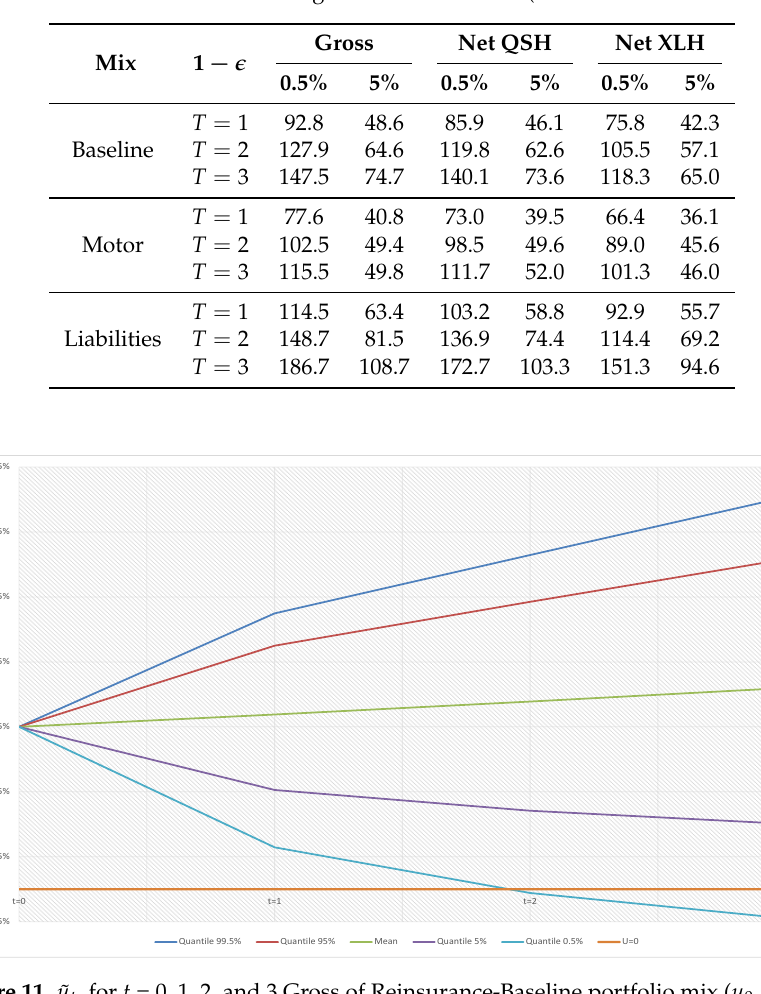
Figure 11. ˜ u t , for t = 0, 1, 2, and 3 Gross of Reinsurance-Baseline portfolio mix ( u 0 =